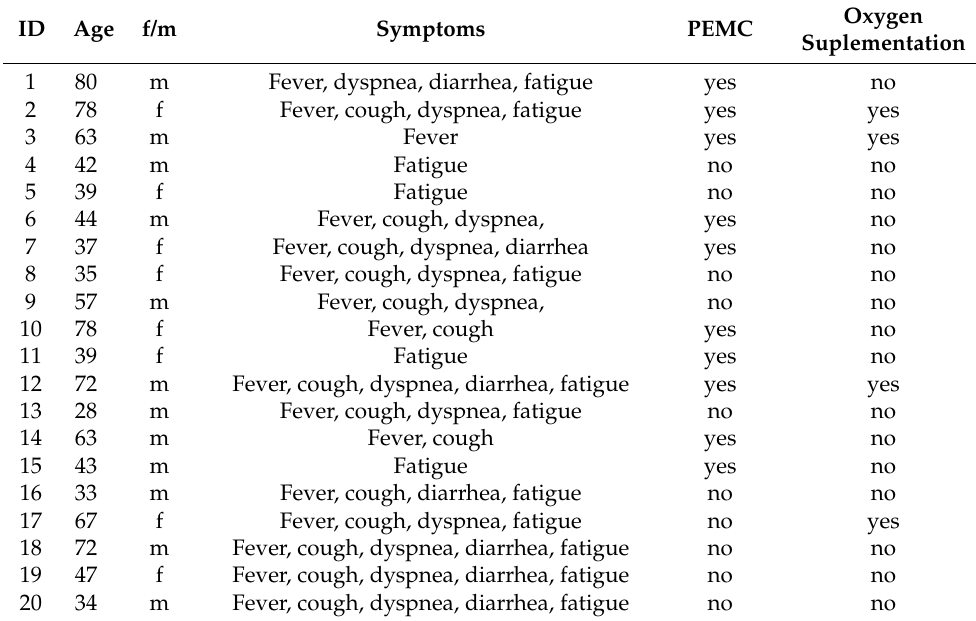
Table A1. COVID-19 patients’ characteristics.